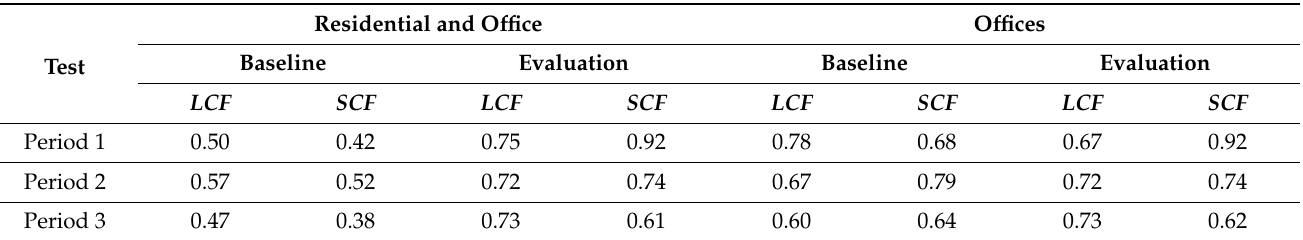
Table 4. LCF and SCF before and after the